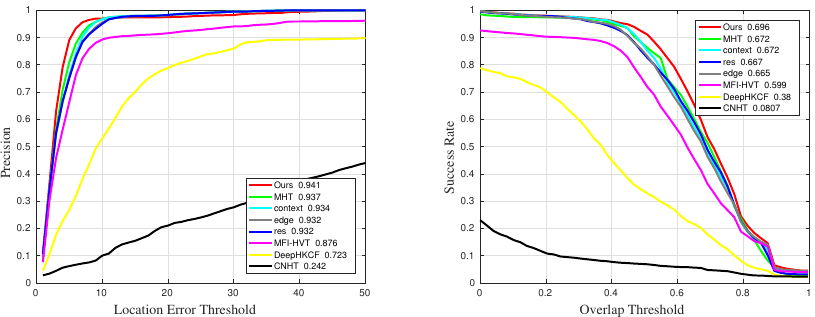
Figure 17. Precision and success rate under the overall sequence.